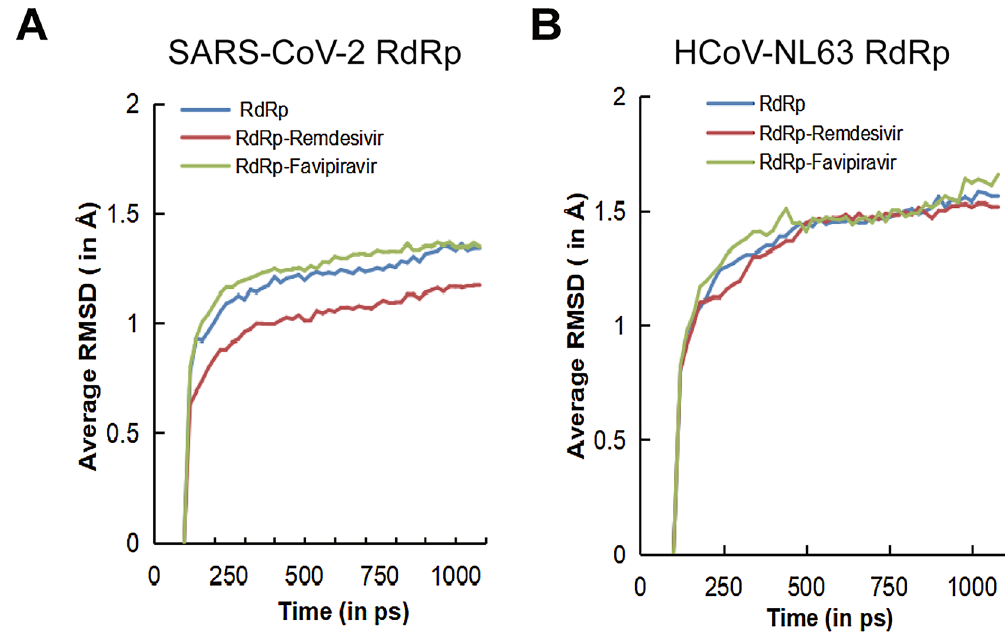
atoms (Blue line) and its complexes with favipiravir (Green Line) or remdesivir (Red line) were plotted against the total simulation time. ( B ) The average RMSDs of HCoV-NL63 RdRp backbone